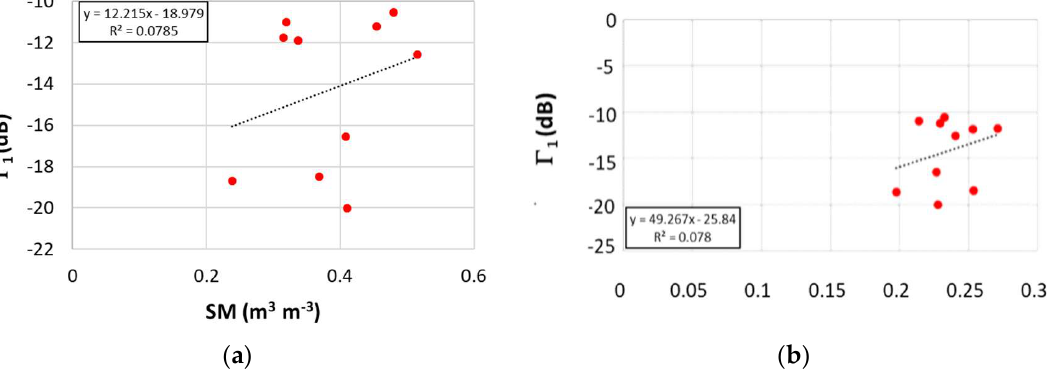
Figure 17. Scatter plot TDS-1 GNSS-R reflectivity (all corrections included) and ( a ) 50 cm depth LISFLOOD soil moisture [m 3 /m 3 ] for Andaraí station, and ( b ) 1 m depth MUSA soil moisture for 2015.